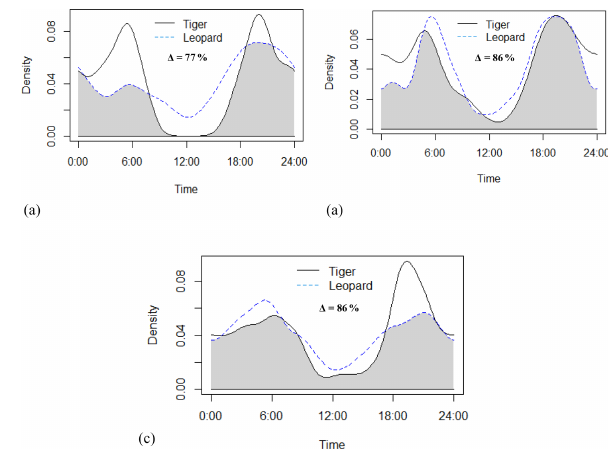
Figure B4. Activity curves and extent of temporal overlap between tiger and leopard in (a) low tiger density, (b) medium tiger density, and (c) high tiger density areas in Pench Tiger Reserve, Madhya Pradesh.